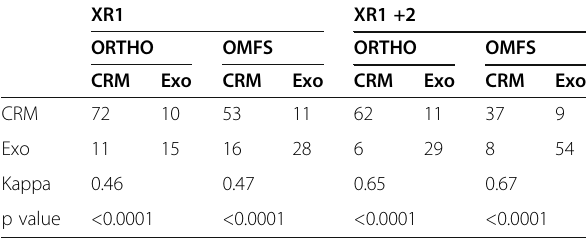
Table 1 Intra-examiner concordance of oralmaxillofacial surgeons (OMFS) and orthodontists (ORTHO) when examined one (XR1) or two serial (XR1 + XR2) radiographs